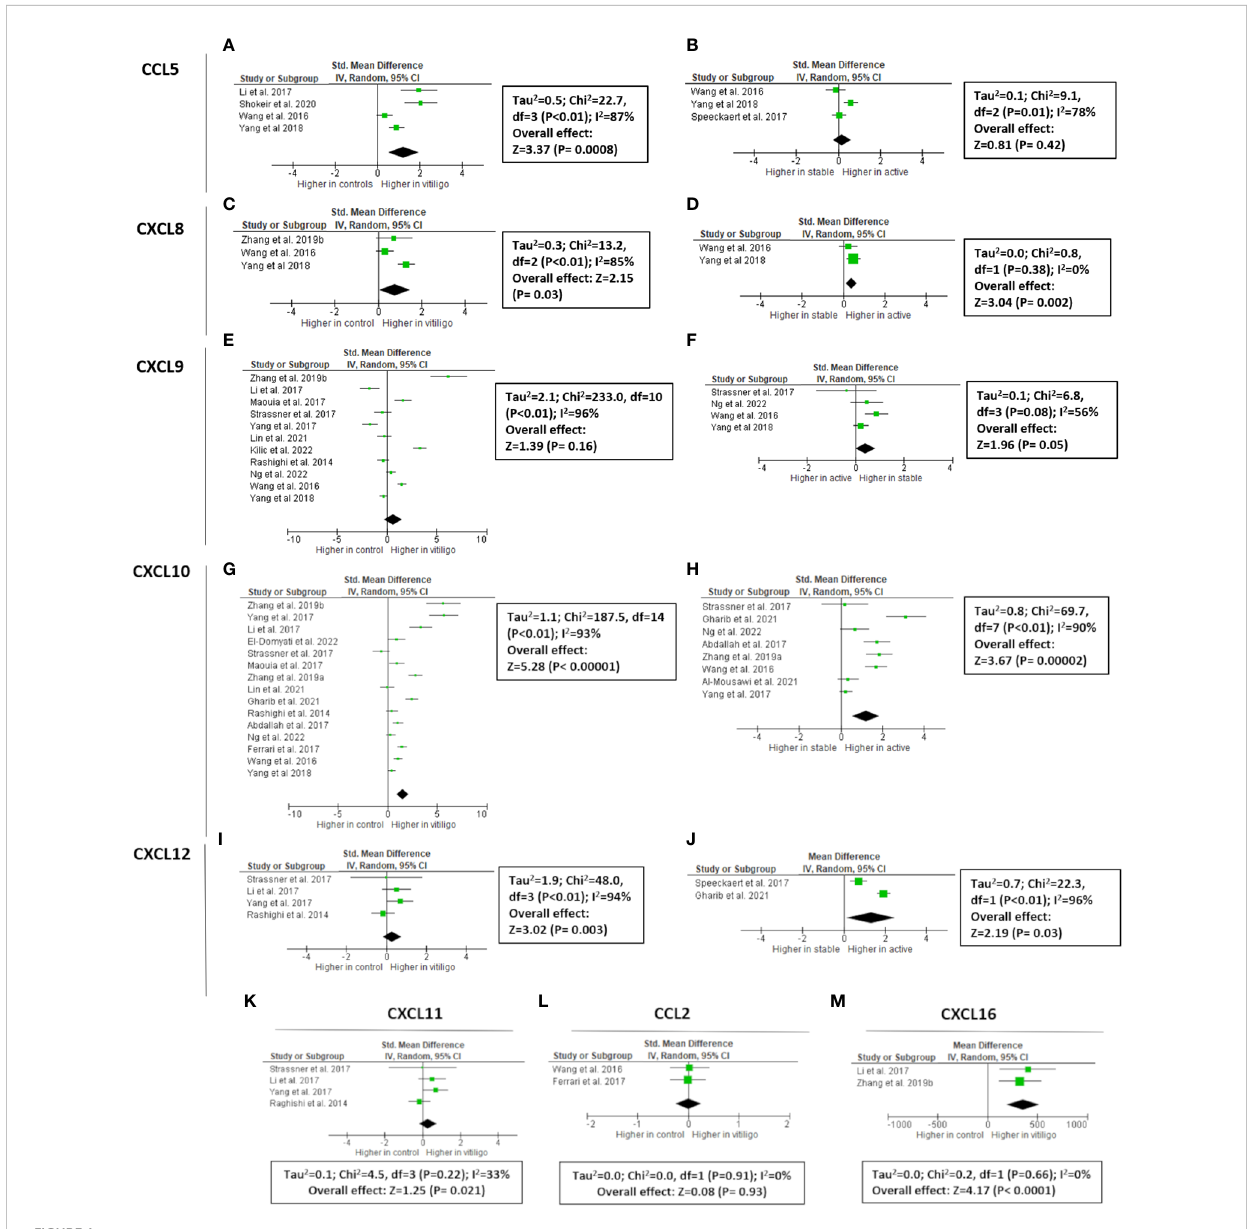
FIGURE 1 Meta-analysis of circulating chemokines of vitiligo patients versus controls or active versus stable patients for CCL5 (A , B , respectively), CXCL8 ( C , D , respectively), CXCL9 ( E , F , respectively), CXCL10 ( G , H , respectively), CXCL11 (K) , CXCL12 ( I , J , respectively), CCL2 (L) , and CXCL16 (M) . CCL: chemokine (C-C motif) ligand; CXCL: chemokine (C-X-C motif)